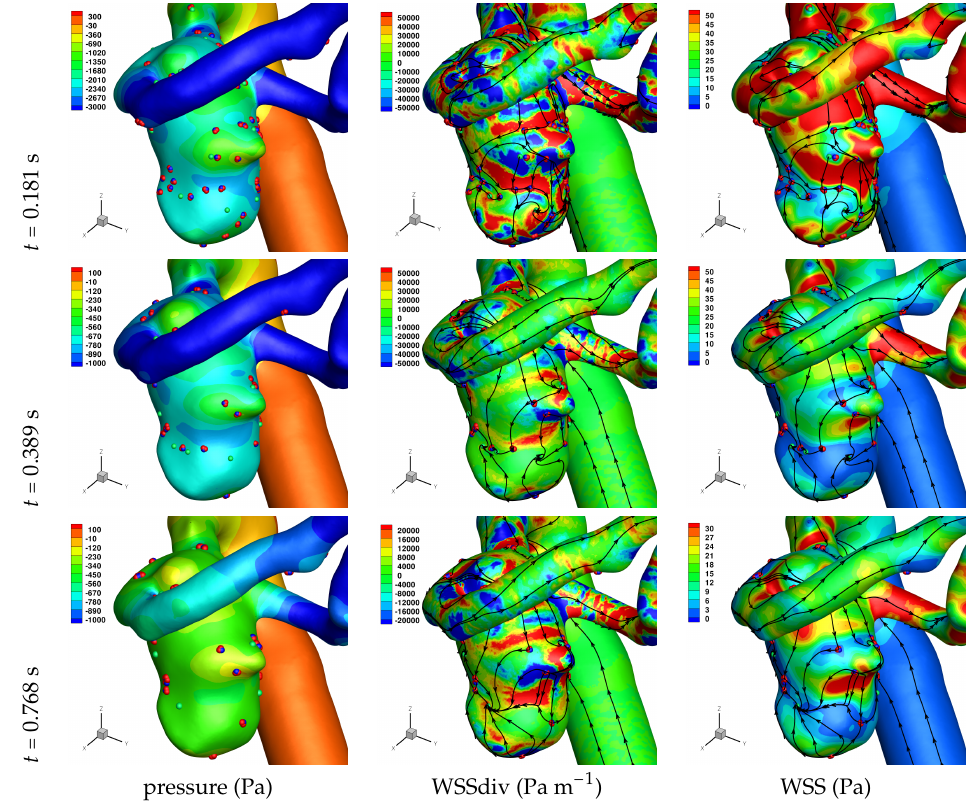
Figure 6. Solution for Case 3. Plots of surface shear lines and WSS critical points (colouring scheme as in Figure 3).